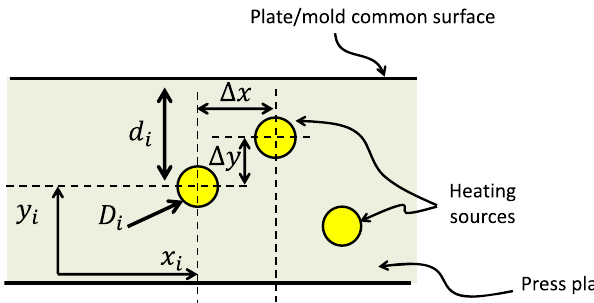
Fig. 2. Parameters de fi ning the position of individual heating